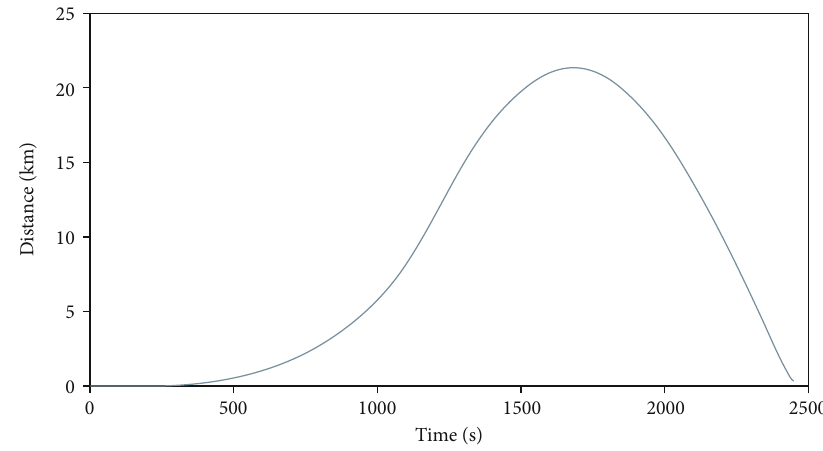
Figure 10: The variation of distance between the active spacecraft and the goal. Table 3: States of the spacecraft and the goal under the ECI coordinate system at the initial moment of the stage of returning from a close proximity.